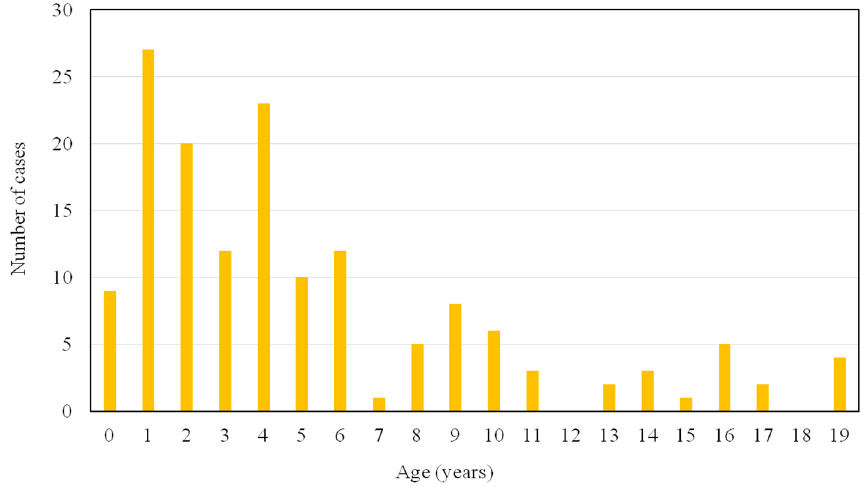
Figure 1. The age distribution of the 153 urine samples collected in this study.